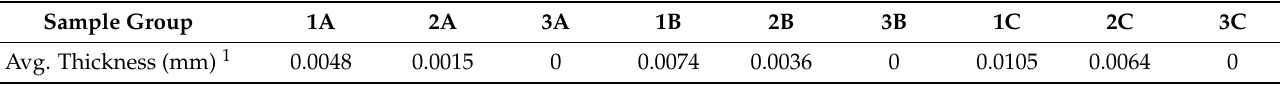
Table 5. Average values of the length of cracks in the base material.